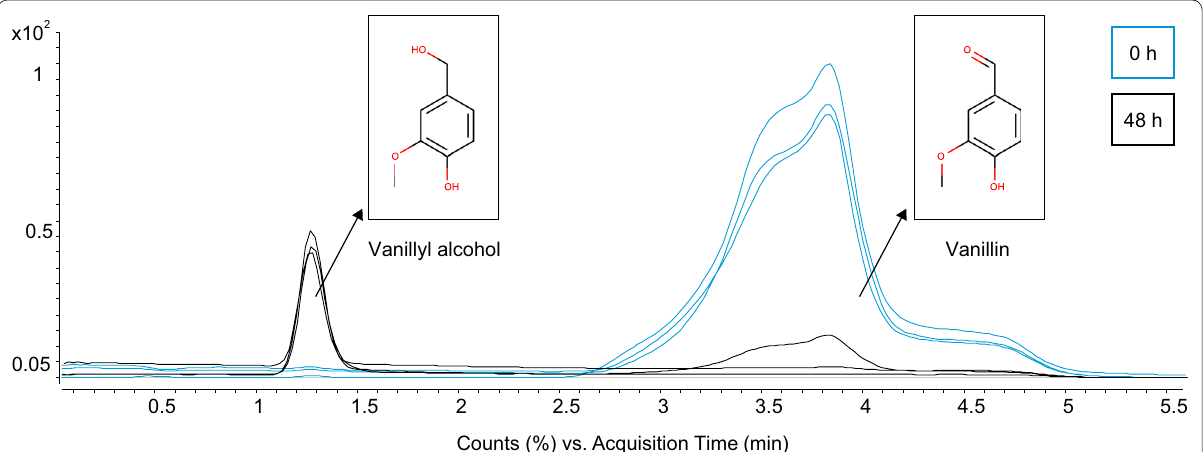
Fig. 1 LC–QTOF–MS run of 0 h and 48 h cultures in triplicate, showing vanillin and the first biodegradation peak detected in a MeOH:H 2 O gradient elutant system comprising 7 min. No peak was detected in the negative